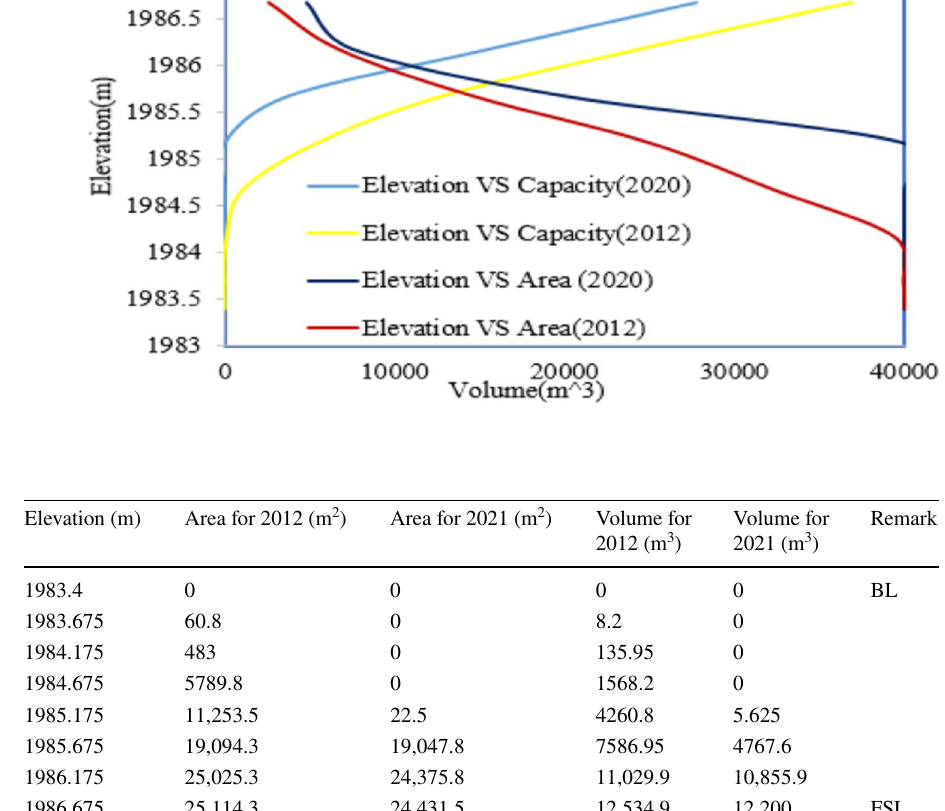
Fig. 11 Adebra NSR Area Elevations and Capacity Eleva- tion Curve